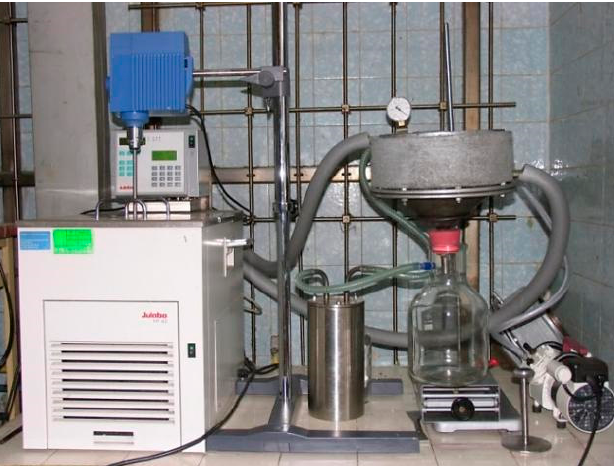
Figure 1. Laboratory stand to model the solvent dewaxing process (INiG-PIB photograph).